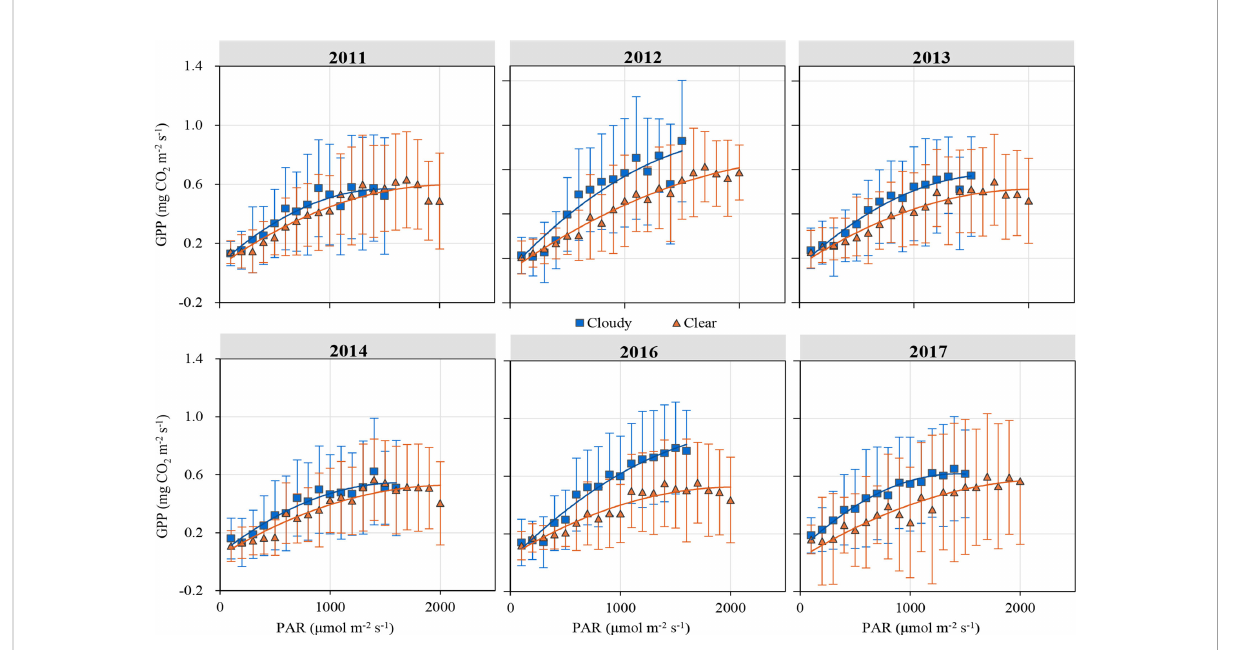
TABLE 1 Light response parameters estimated by the MM model under different sky conditions.